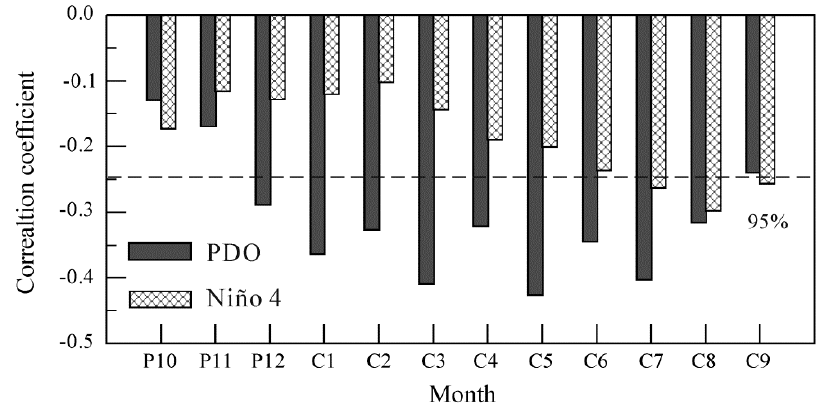
Figure 7. Correlations between reconstructed January–September mean self-calibrating Palmer Drought Severity Index and the PDO [47] and el Niño 4 indices [27] in the period of 1950–2013. P indicates the previous year, C indicates the current year. The dashed line indicates the confidence level of 95%.